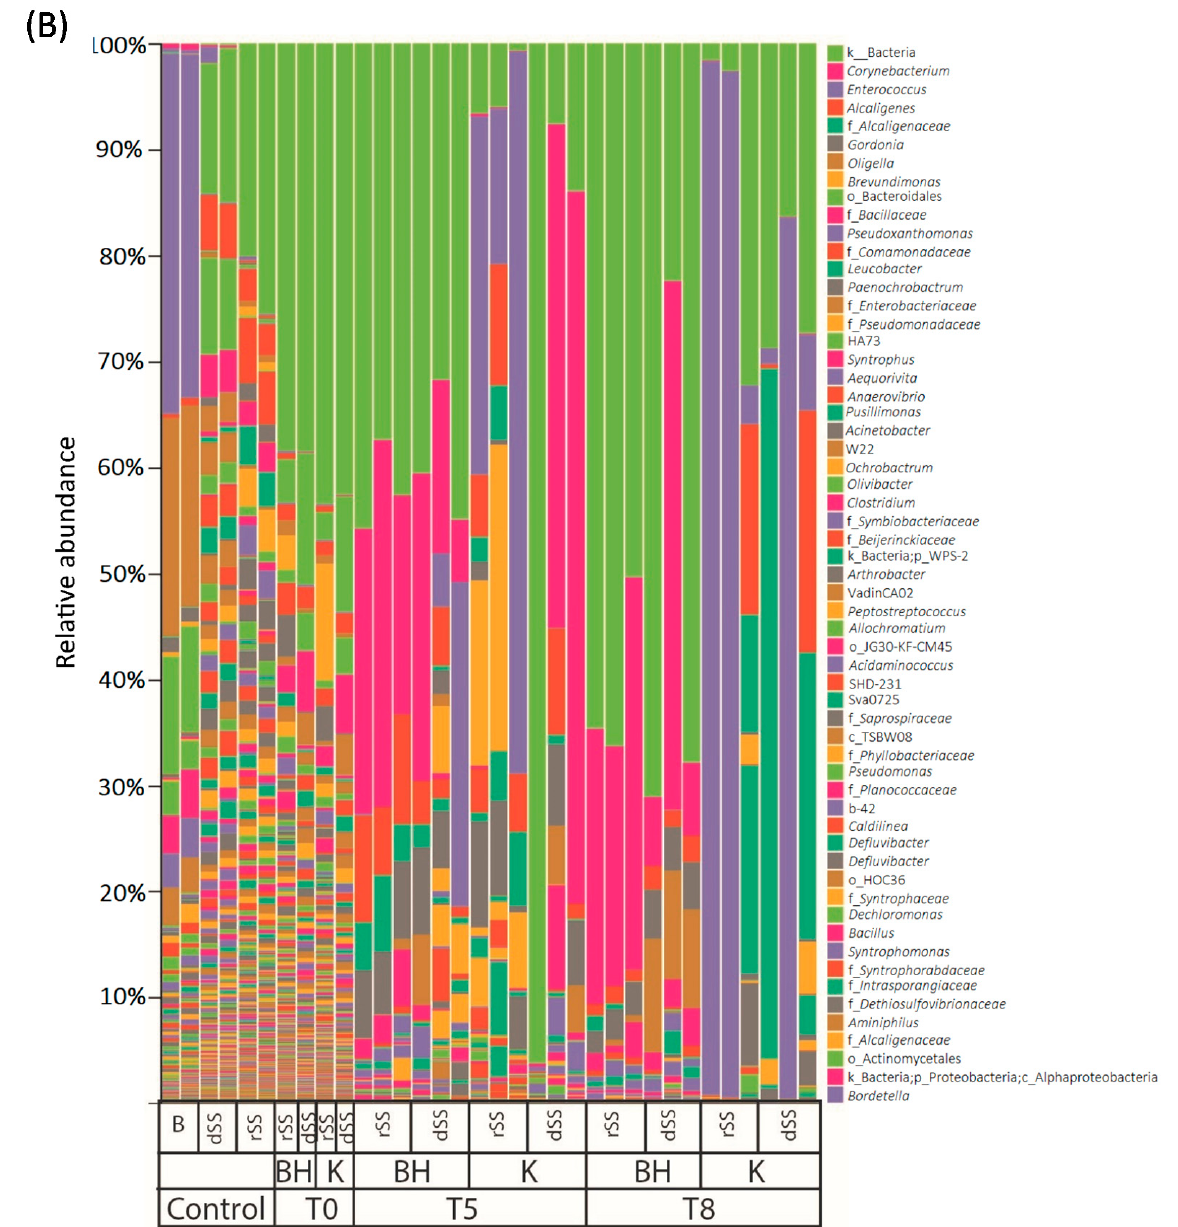
Figure 2. Relative abundance (%) in different media over time in the selective pressure experiments: ( A ) Fungal diversity and ( B ) bacterial diversity. B: Bulking, dSS: Digested Sewage Sludge, rSS: Raw Sewage Sludge, BH: Bushnell Hass Medium, K: Kirk medium, T: Time in weeks. BH medium favored the proliferation of Actinomycetales and Burkholderiales in rSS.